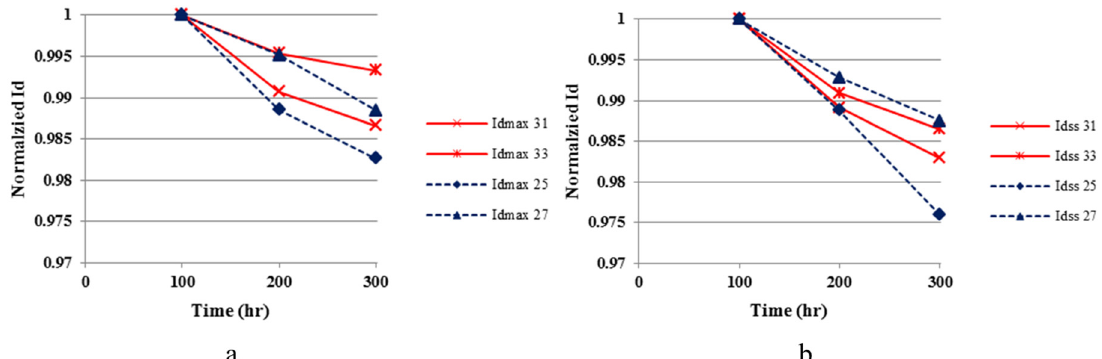
Figure 2. Normalized (to the 100 h measurements) pre- and post- stress values of ( a ) maximum drain current ( I Dmax ) and ( b ) steady state drain current ( I DSS )for the 300 h high-voltage conditions. The top two lines (red) of the legend are Condition 4, and the bottom two (blue) are Condition 5.